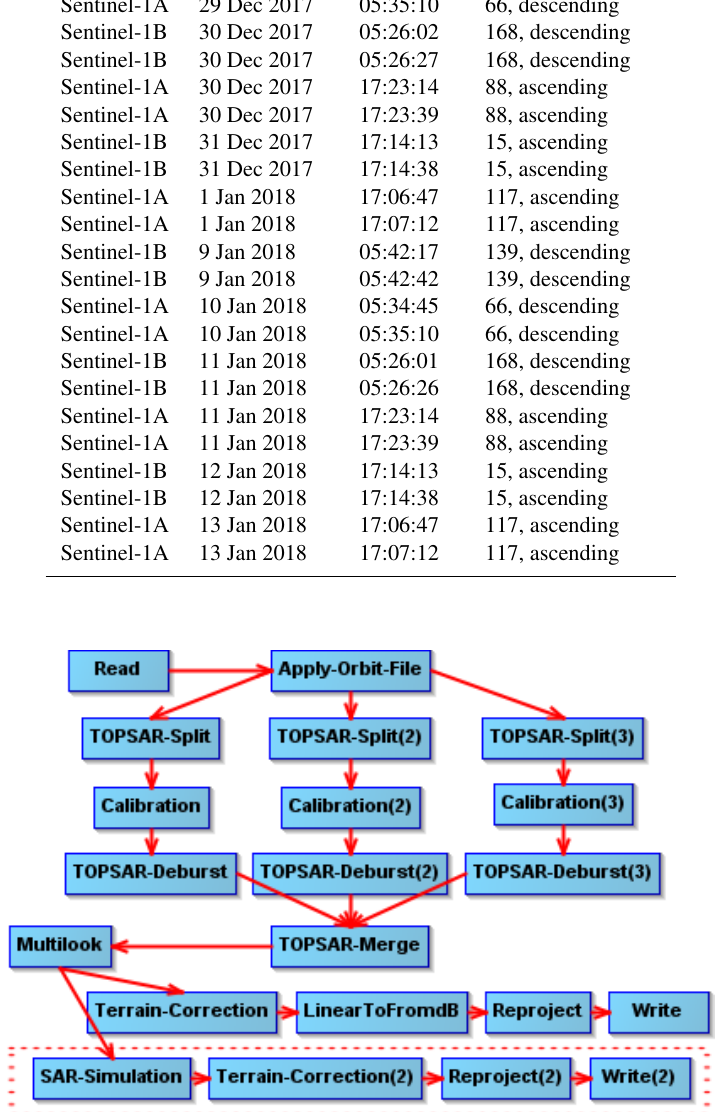
Figure A1. SNAP workflow to process S1 data. The red dashed box is used for creation of the layover and shadow